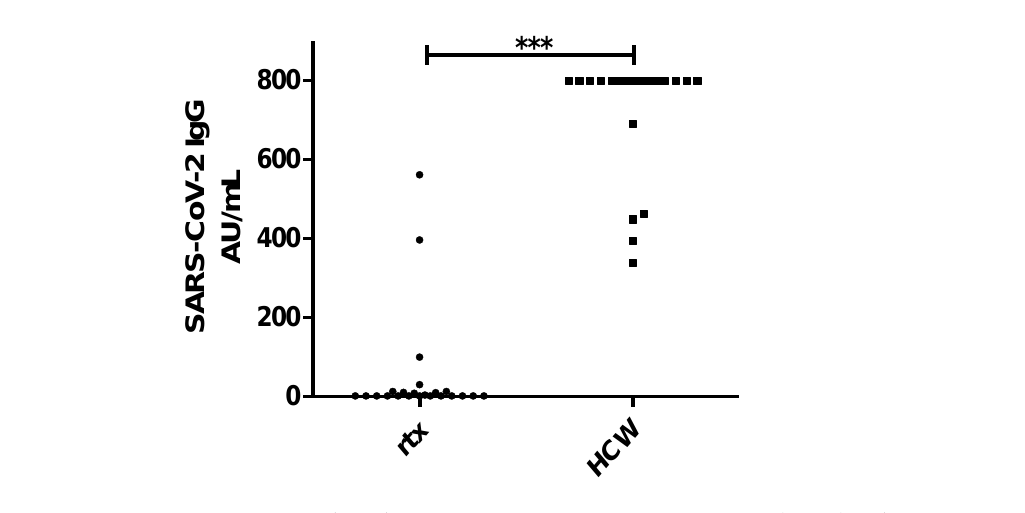
Table 2. Characteristics of renal transplant recipients who tested positive and negative for SARS.CoV-2 IgG after two doses of the mRNA-based SARS-CoV-2 vaccine BNT162b2.